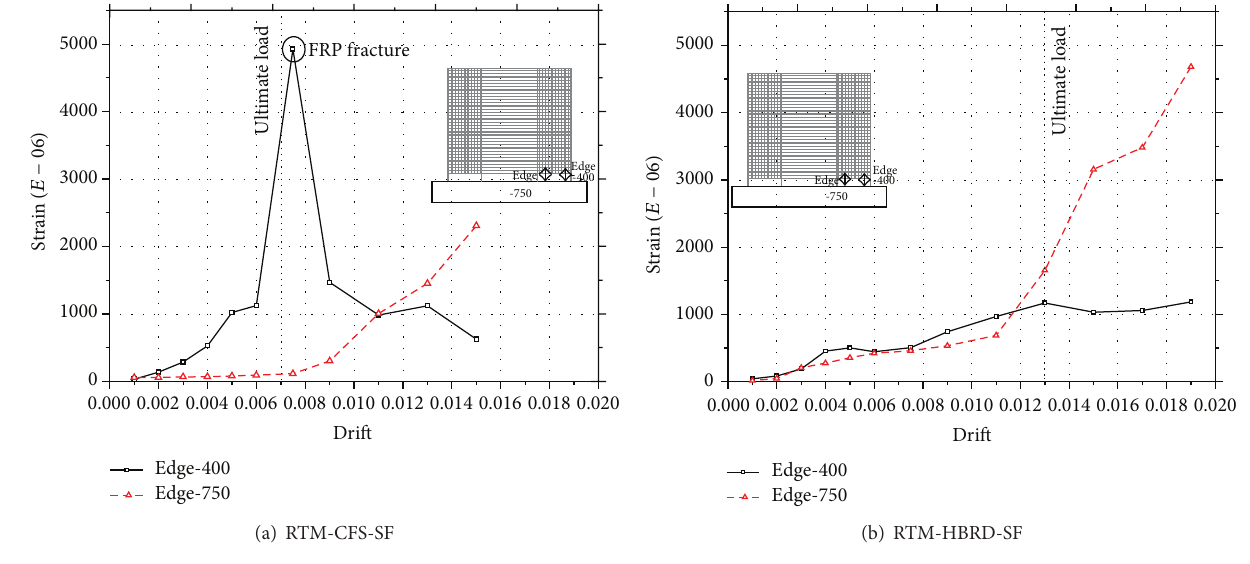
Figure 9: FRP sheet strain (vertical direction).